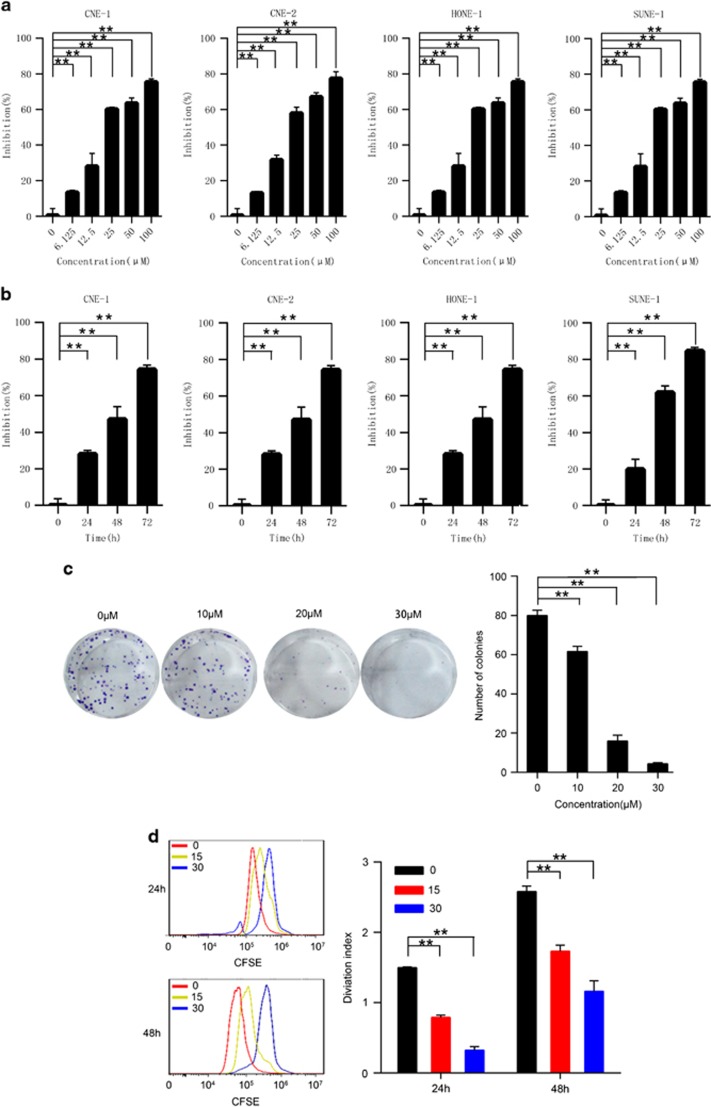
Cardamonin inhibits proliferation and division of NPC cells. (a) CNE-1, CNE-2, HONE-1 and SUNE-1 cells were treated with different concentrations of cardamonin or 0.1% DMSO for 24 h. Cellular viability was measured with a CCK-8 assay, **P<0.01, n=3. (b) NPC cells were treated with 10 μM cardamonin or 0.1% DMSO, absorbance was measured after 24, 48 and 72 h of treatment. (c) CNE-2 cells were cultured for 7 days after treatment with varying concentration of cardamonin, and stained with 0.1% crystal violet. Colonies containing >50 cells were counted, **P<0.01, n=3. (d) CFSE labeled cells were measured using flow cytometry after treatment with cardamonin. **P<0.01, n=3